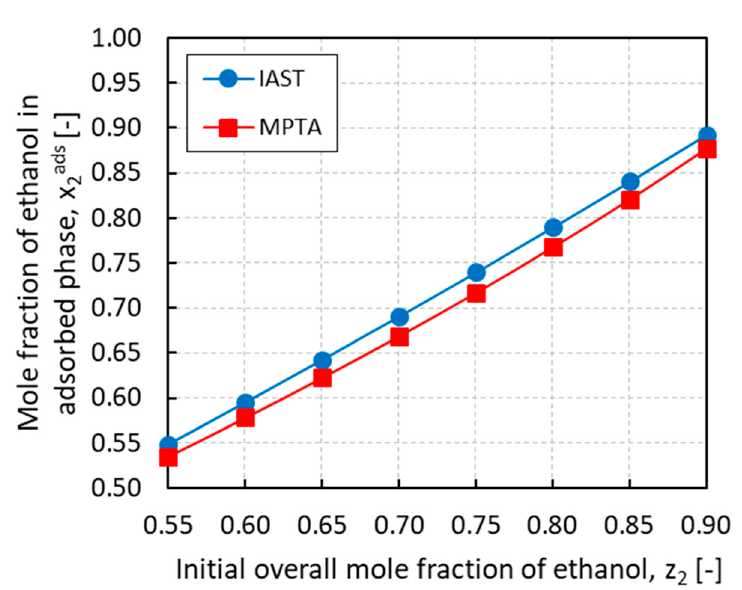
Figure 9. Mole fraction of ethanol in the adsorbed phase x 2 ads calculated with ideal adsorbed solution theory (IAST) and multicomponent potential theory of adsorption (MPTA) methods vs. the initial overall mole fraction of ethanol z 2 .